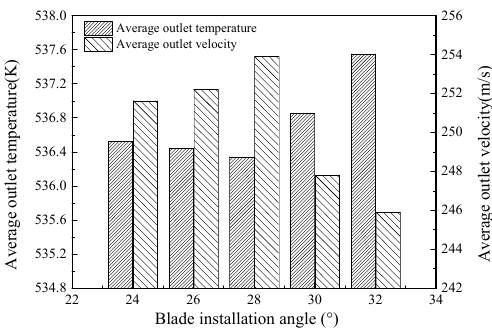
Figure 10. Average outlet temperature and average outlet velocity for stator blade with blade number 32.